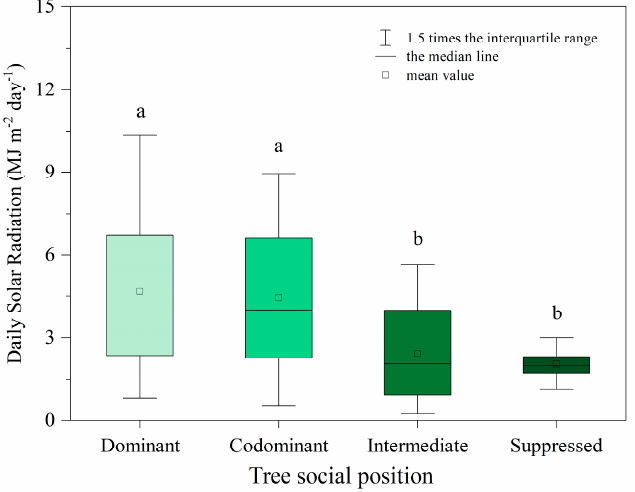
Figure 6. The differences in the solar radiation income of individual trees among social position levels in the down slope plot. Groups marked by different letters significantly differ from each other (i.e., a is significantly greater than b ) (p ≤ 0.05).